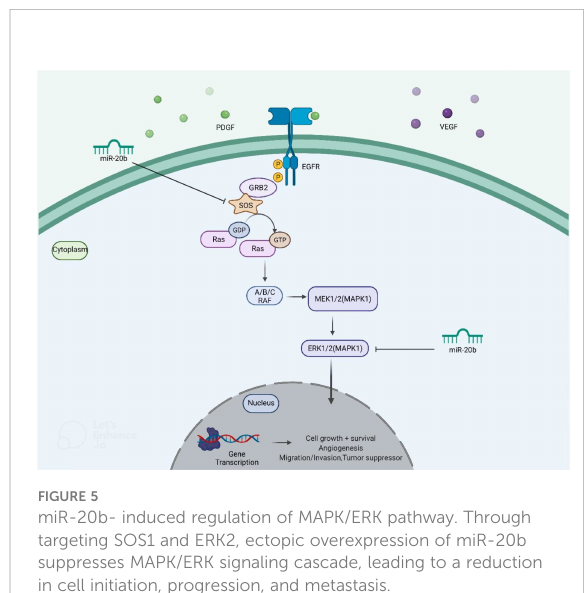
FIGURE 5 miR-20b- induced regulation of MAPK/ERK pathway. Through targeting SOS1 and ERK2, ectopic overexpression of miR-20b suppresses MAPK/ERK signaling cascade, leading to a reduction in cell initiation, progression, and